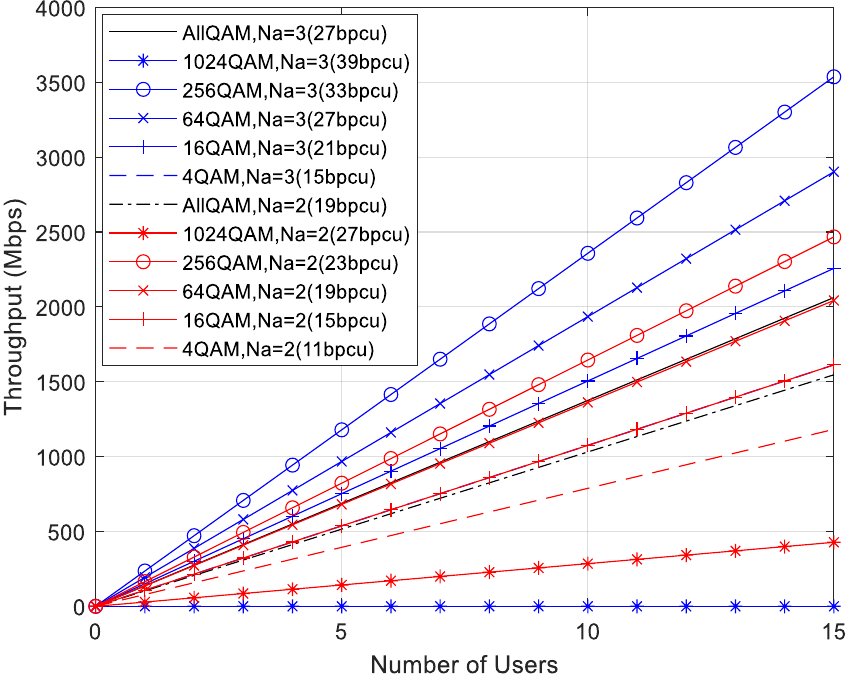
Figure 11. Average throughput vs number of users for N sc = 256, N tx = 17 antennas / user, and N rx = 16 antennas / user with imperfect channel estimation. Appl. Sci. 2020 , 10 , x FOR PEER REVIEW